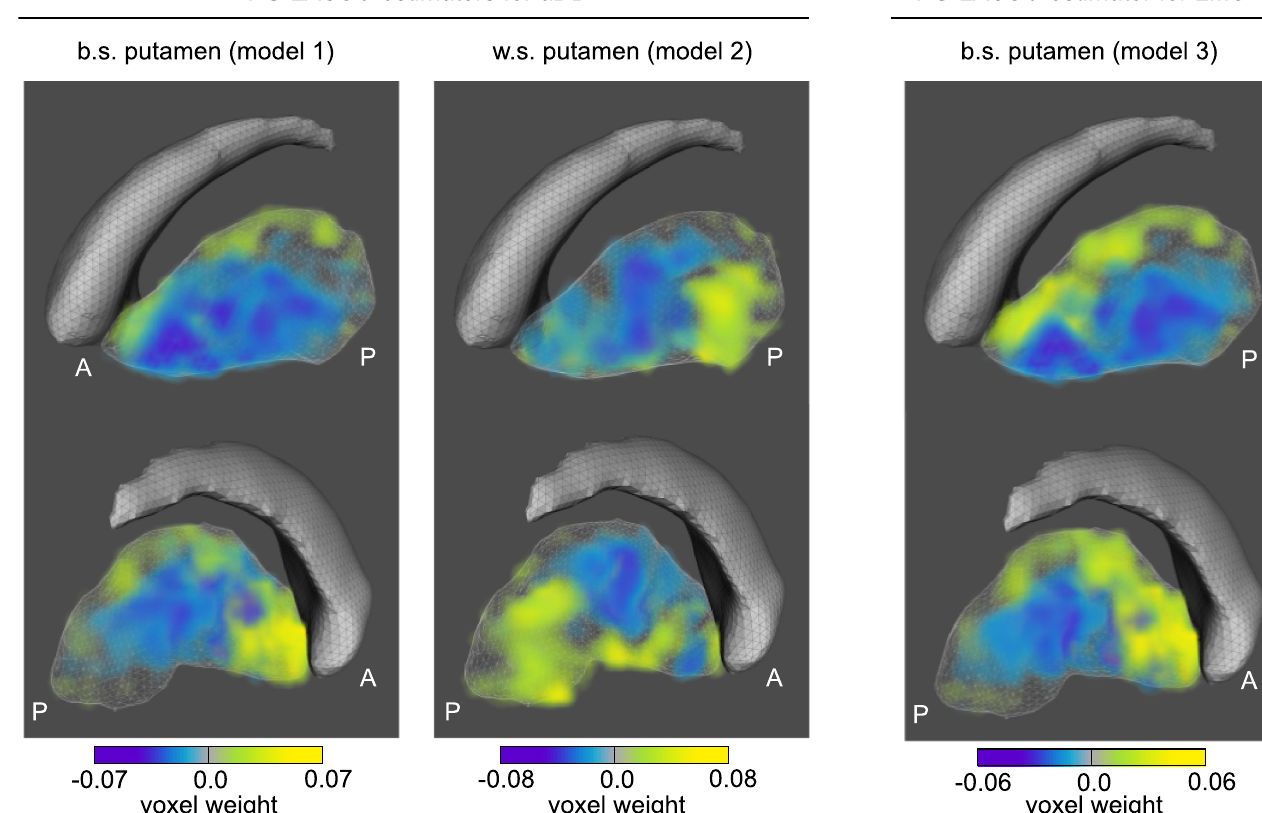
Fig 8. Voxel weight distributions in the DTBZ-based PC-LASSO estimators of aDD and better-side LMS in the putamen. Caudate is shown for spatial that were fitted on all data. Front view at the top, back view at the bottom. A = anterior; P = reference. The estimators were computed using β j